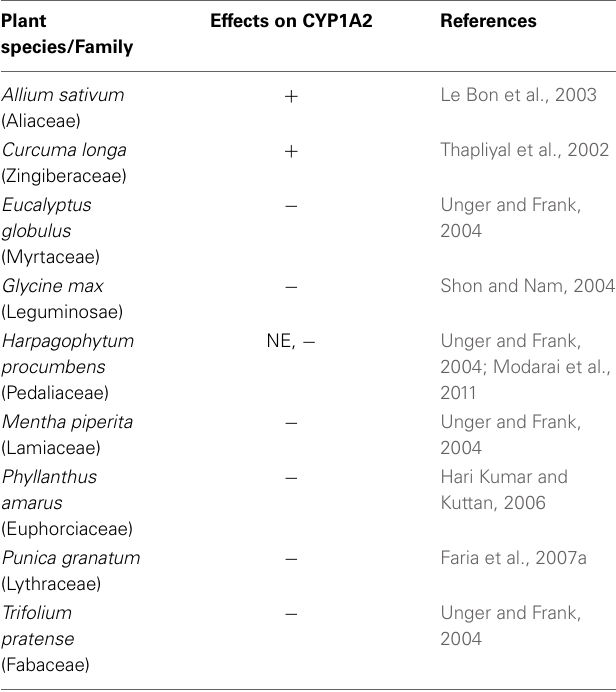
Table 1 | Medicinal plant species listed in RENISUS with reported effects of on